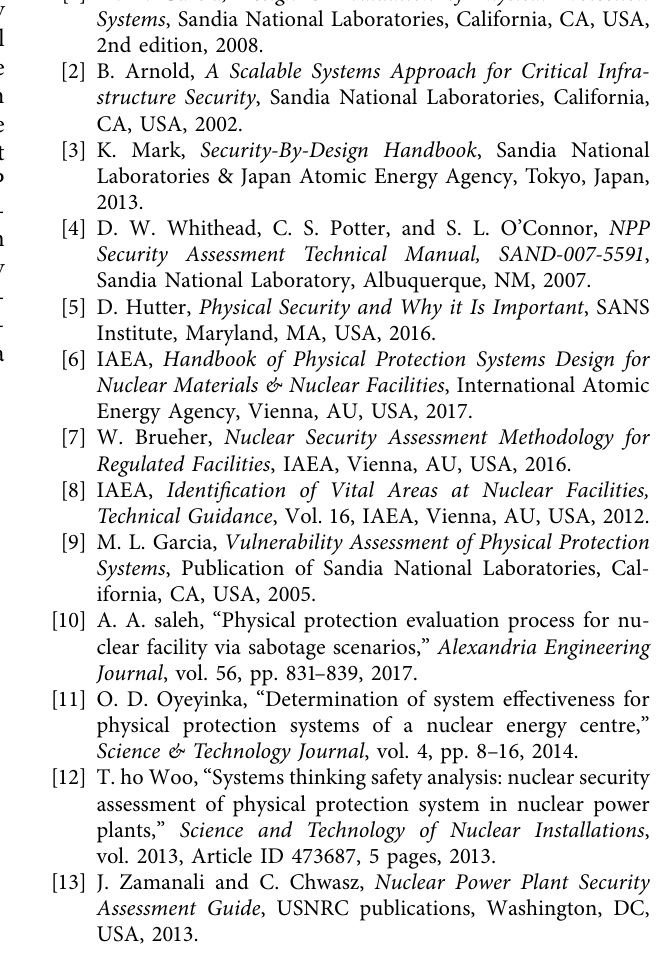
Figure 15: P E versus risk for two scenarios 1.1 (the lowest scenario 1.4 (the best P E ) shows the reverse relationship between risk and effectiveness probability P E . The curves of P E and risk are on the x -axis of the